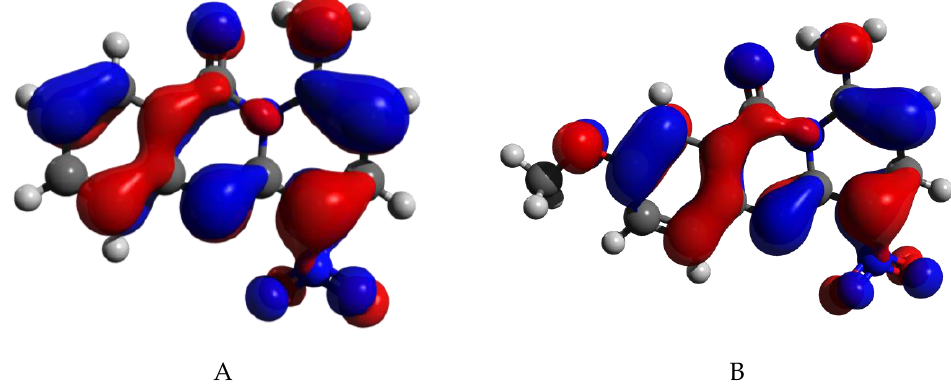
Figure3. TheHOMOorbitalsofthenon-methoxy-substitutedanalogue( A )andthemethoxy-substituted Figure 3. The HOMO orbitals of the non-methoxy-substituted analogue ( A ) and the methoxy- analogue ( B substituted analogue ( B ).